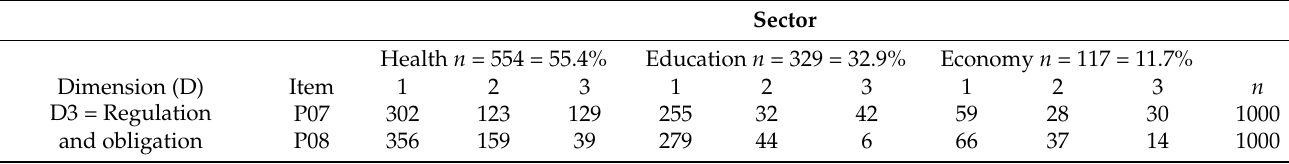
Table 7. Count by sector of the participating sample for dimension